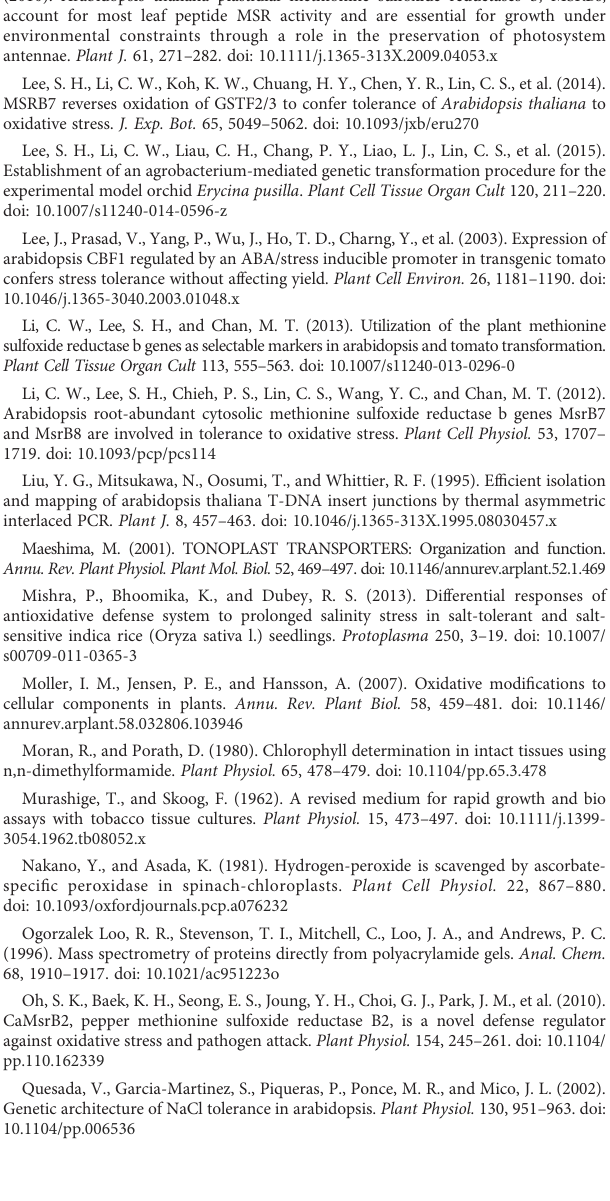
SUPPLEMENTARY FIGURE 3 Transcription pro fi les of MSRB5 and MSRB6 in overexpressing lines of MSRB5 (B5OX), MSRB6 (B6OX) and MSRB5 plus MSRB6 (B5OX + B6OX) in a Columbia ecotype were detected by qRT-PCR. SUPPLEMENTARY FIGURE 4 Cytosolic location of AtMSRB5 and AtMSRB6 in Arabidopsis. Bar indicates 10 m m.